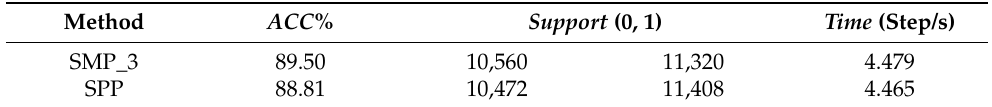
Table 4. Effect of strip pooling on